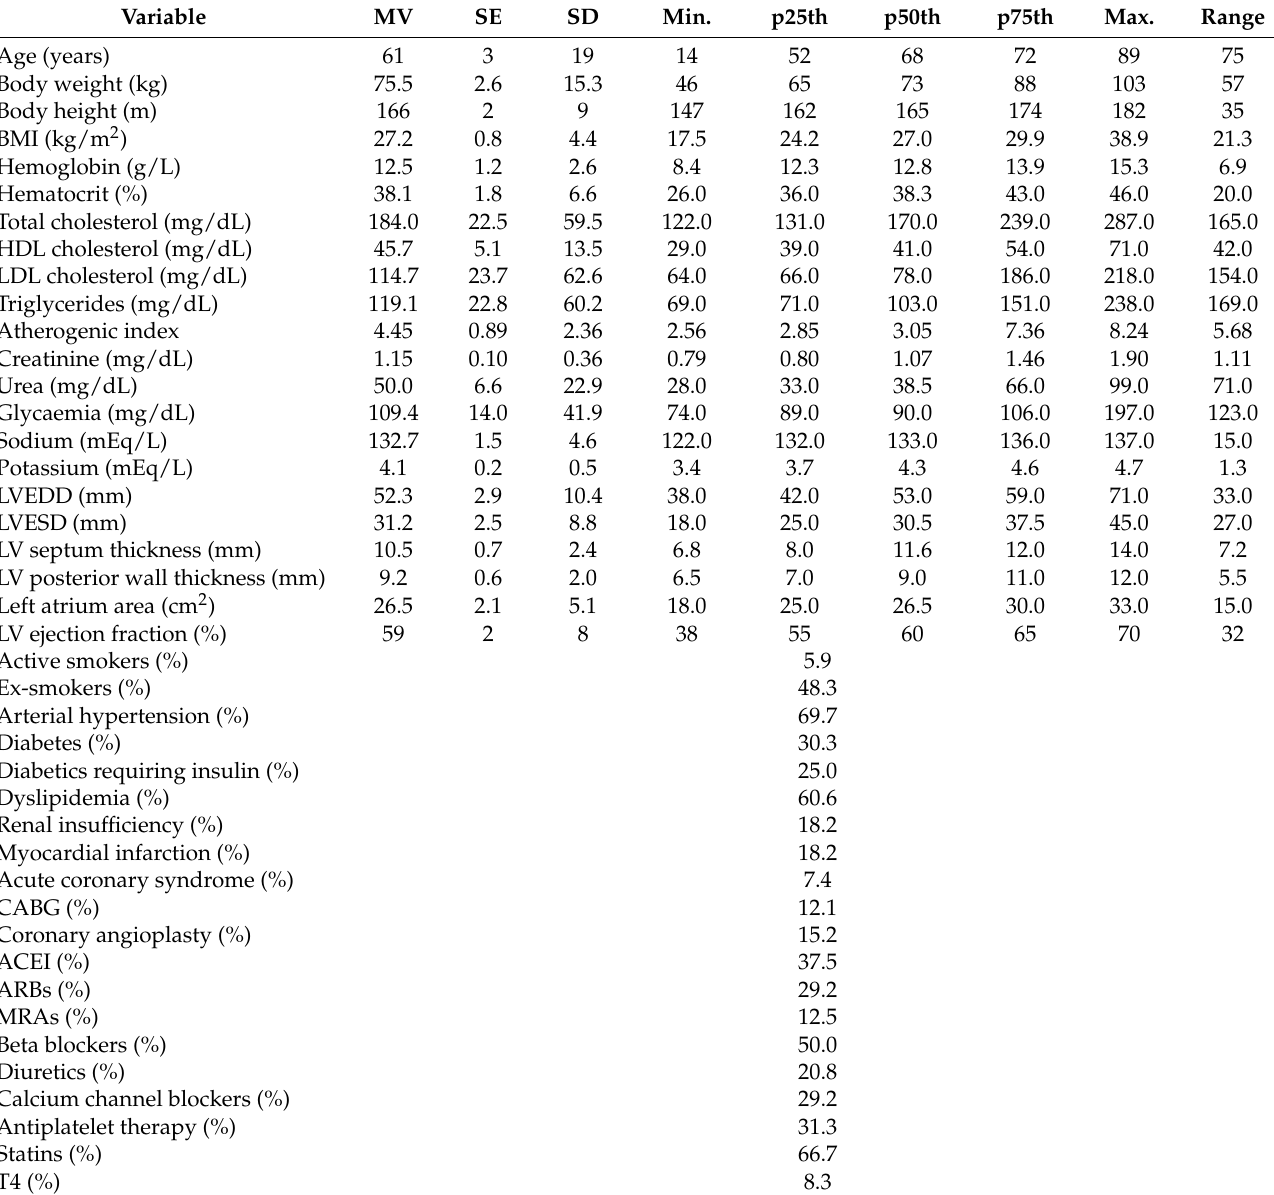
Table 1. Demographic, anthropometric and clinical characteristics (n = 34, 41%